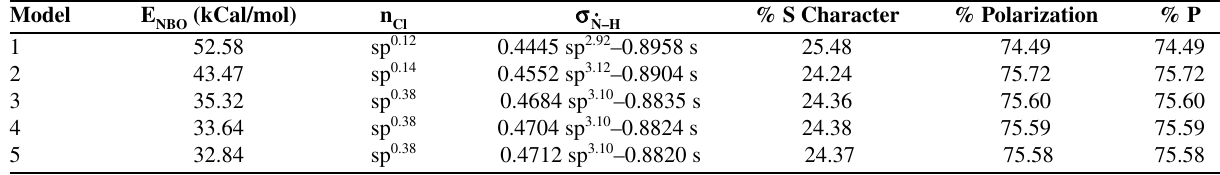
Table 5. NBO analysis of NH(1)–Cl interaction for alanine hydrochloride clusters calculated with M06-2X/6-311++G(d,p) method. Model